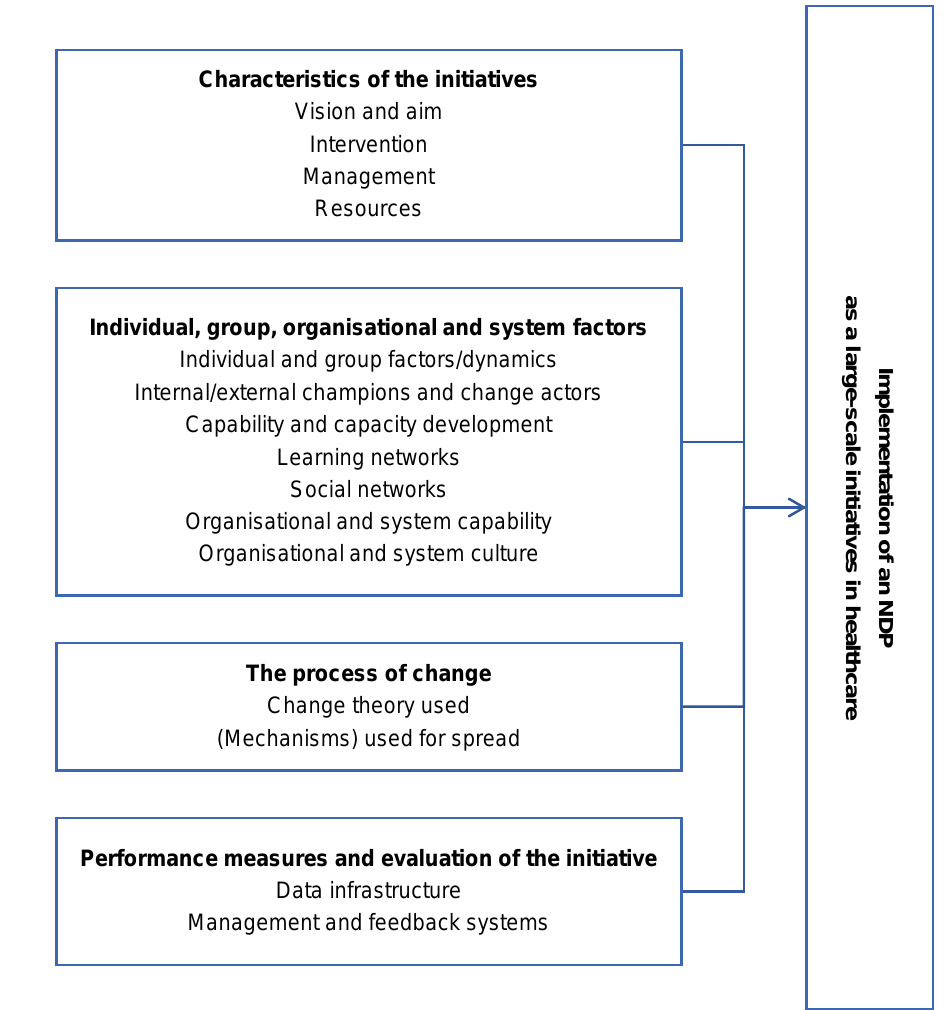
Figure 1. Driver diagram of large-scale change (adapted from Perla et al. [17]).